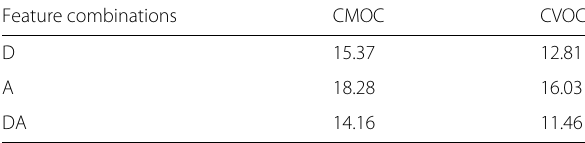
Table 4 Experimental results (EER(%)) on ASVspoof 2017 V2 evaluation set using dynamic features of CMOC and CVOC Feature combinations CMOC